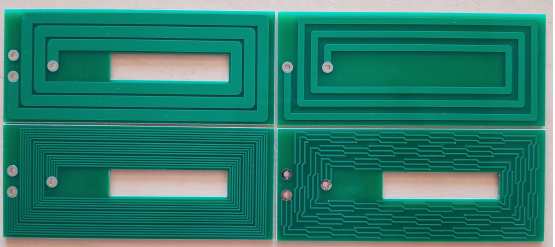
Figure 10. Three turn PCB windings with solid 5 mm ( Top left ), solid 3 mm ( Top right ), multi-strands ( bottom left ) and Litz style ( bottom right